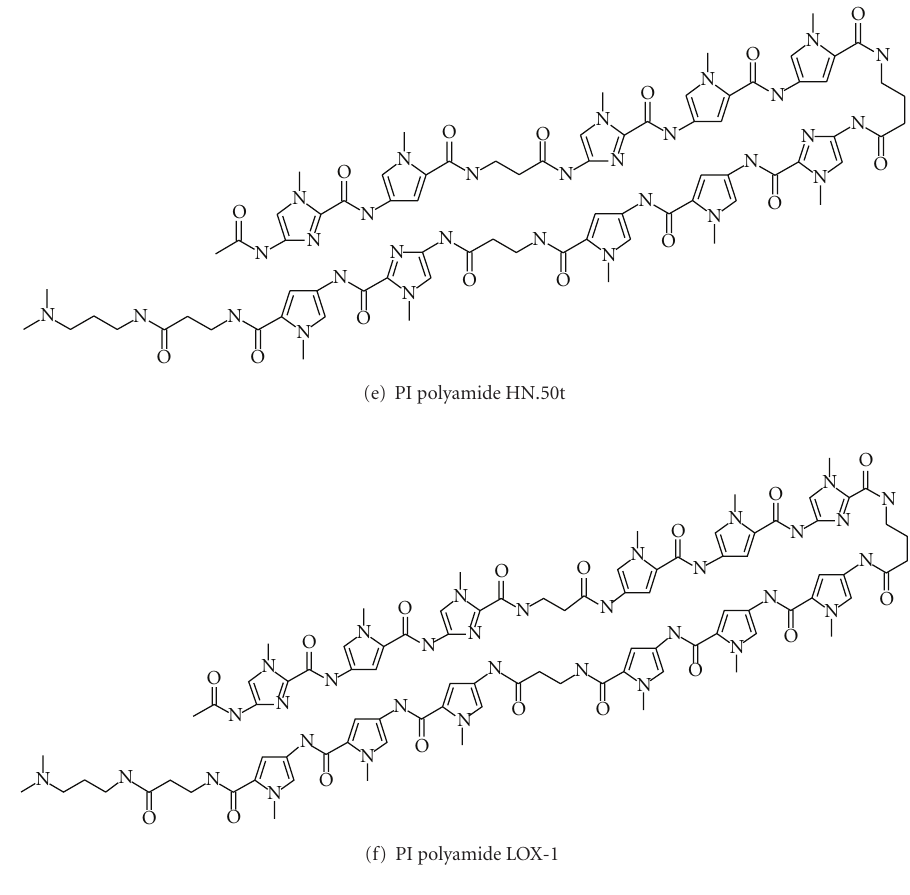
Figure 1: Structures of PI